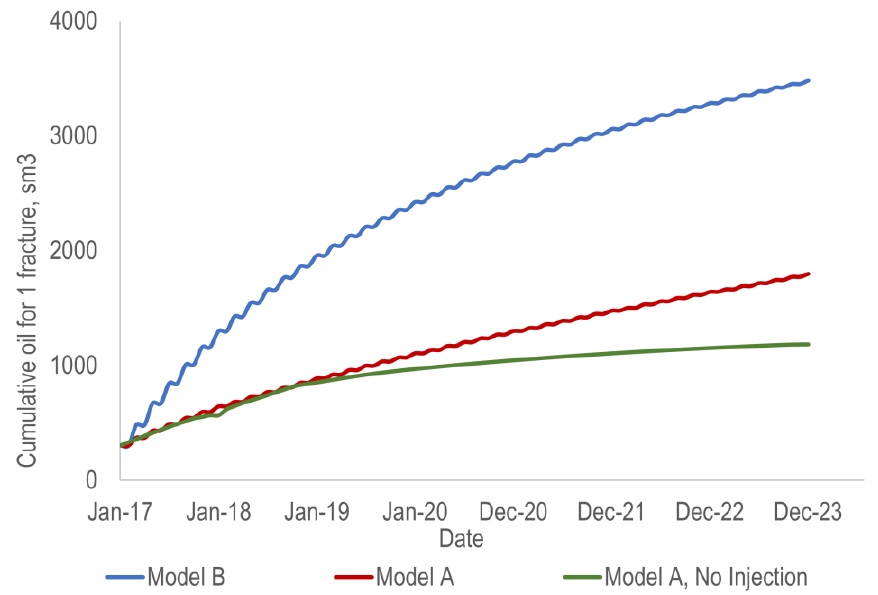
Figure 7. Cumulative oil production for the optimal scenario on models A and B in comparison to the primary production scenario (model A).